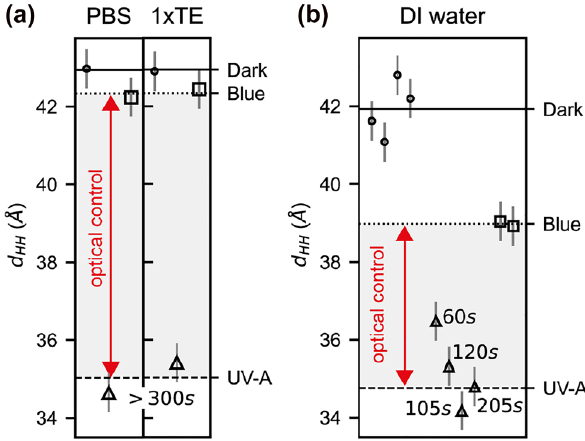
Figure 2: Switching behaviour of photomembranes in buffer and in DI water. (a) Head-to-head distances ( d HH ) obtained for azo-PC SUVs in PBS and 1 × TE buffer. (b) d HH obtained for azo-PC SUVs in DI water. The dark-adapted state, and several photostationary states induced via UV-A and blue light are labelled accordingly. Horizontal lines indi- cate mean values of d HH for the dark-adapted, UV-A, and blue light photostationary states, shown as solid, dashed, and dotted line, respectively. The exposure time of UV-A light while approaching the photostationary state is indicated in seconds. The optical control window for the different buffer conditions is indicated by a red double-headed